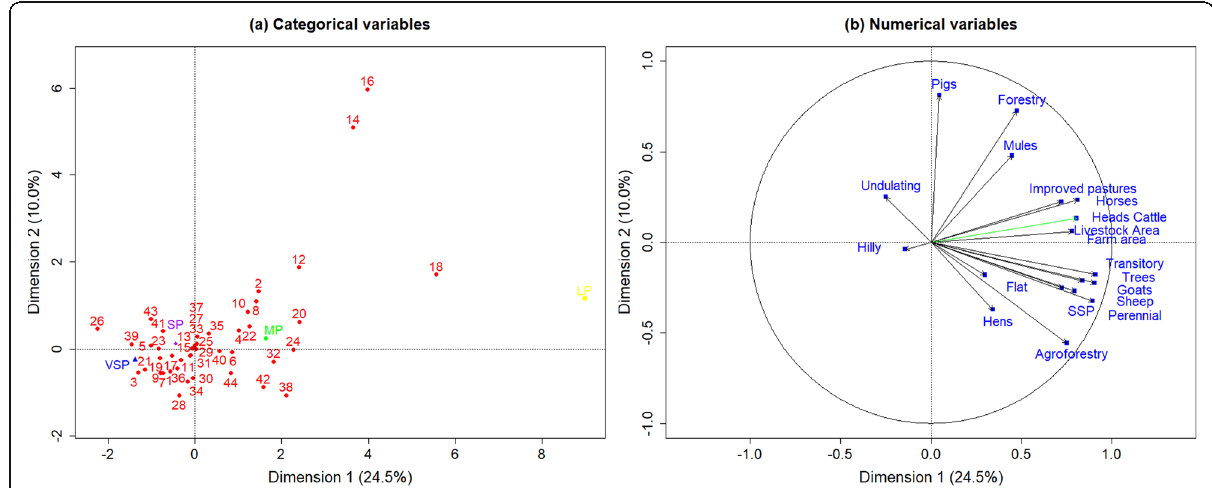
Fig. 2 Spatial projection of a categorical variables and b numerical variables for the component General Farm Information. Coding of categorical and numerical variables is shown in Table S3 of the Supplementary